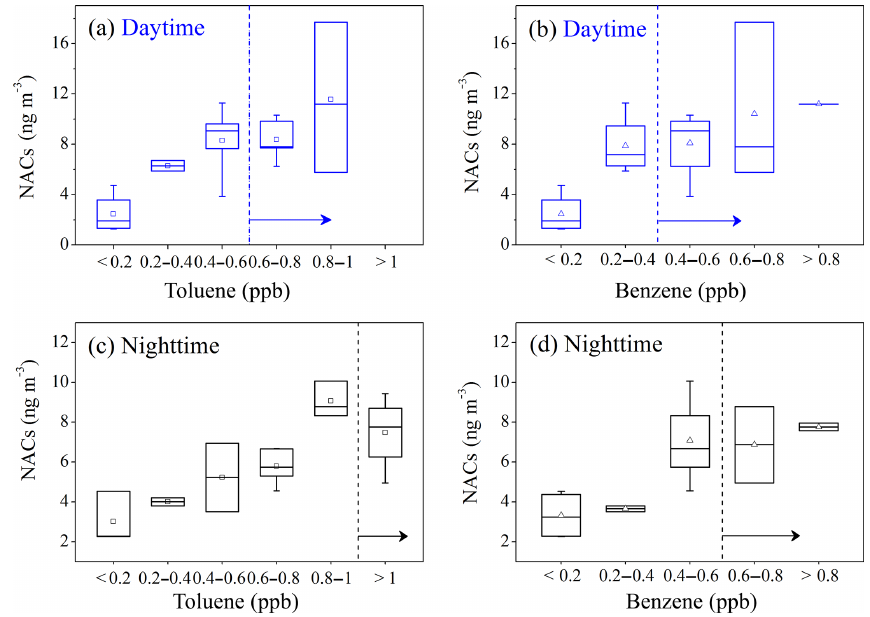
Figure 7. Concentration of NACs as a function of toluene and benzene concentration bins during daytime and nighttime. The markers represent the mean values and whiskers represent the 25th and 75th percentiles.